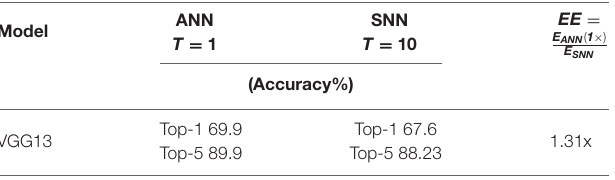
TABLE 16 | Accuracy and Energy Efficiency EE for AGD trained SNN topologies (refer Table 17 ) with hybrid ReLU/LIF neurons of latency T = 10 and corresponding ANN on Imagenet data.